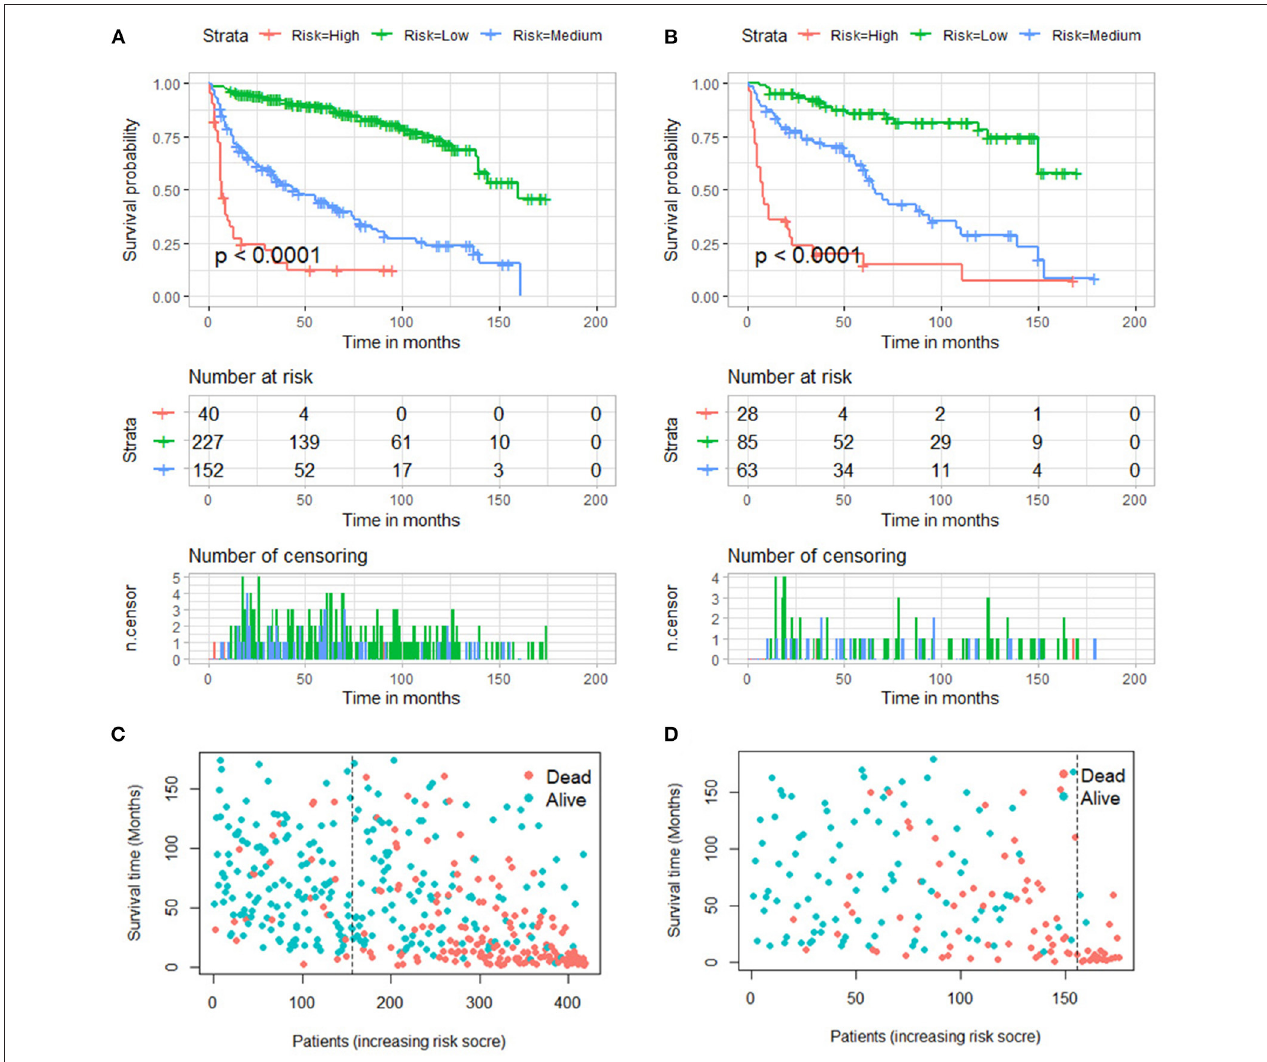
FIGURE 8 | Kaplan–Meier survival curves of three mortality risk subgroups in the training group (A) and validation group (B) . Kaplan–Meier survival status analysis in the training group (C) and validation group (D)